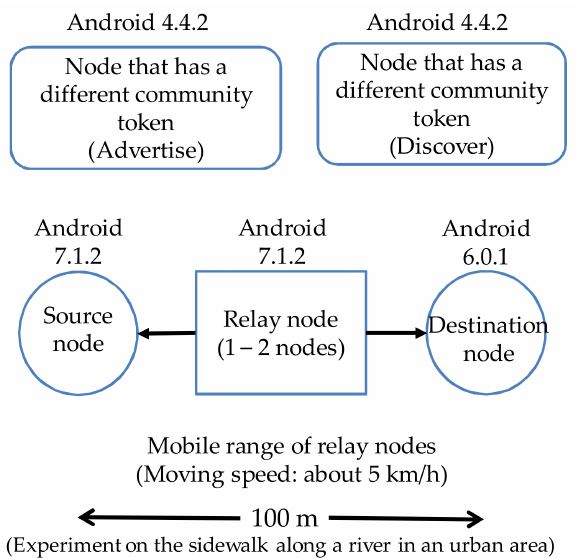
Figure 11. Network structure used in the experiment for a case where terminals belonging to different groups